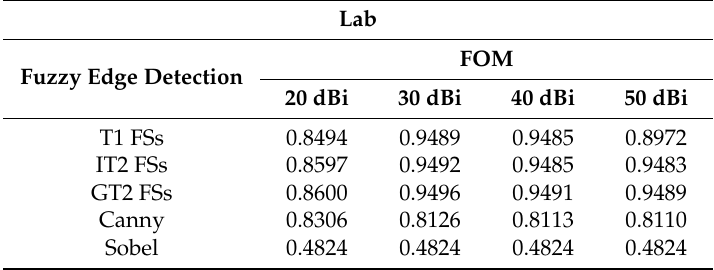
Table 10. T1, IT2, and GT2 FS edge detection applied on Lab color format images with Gaussian